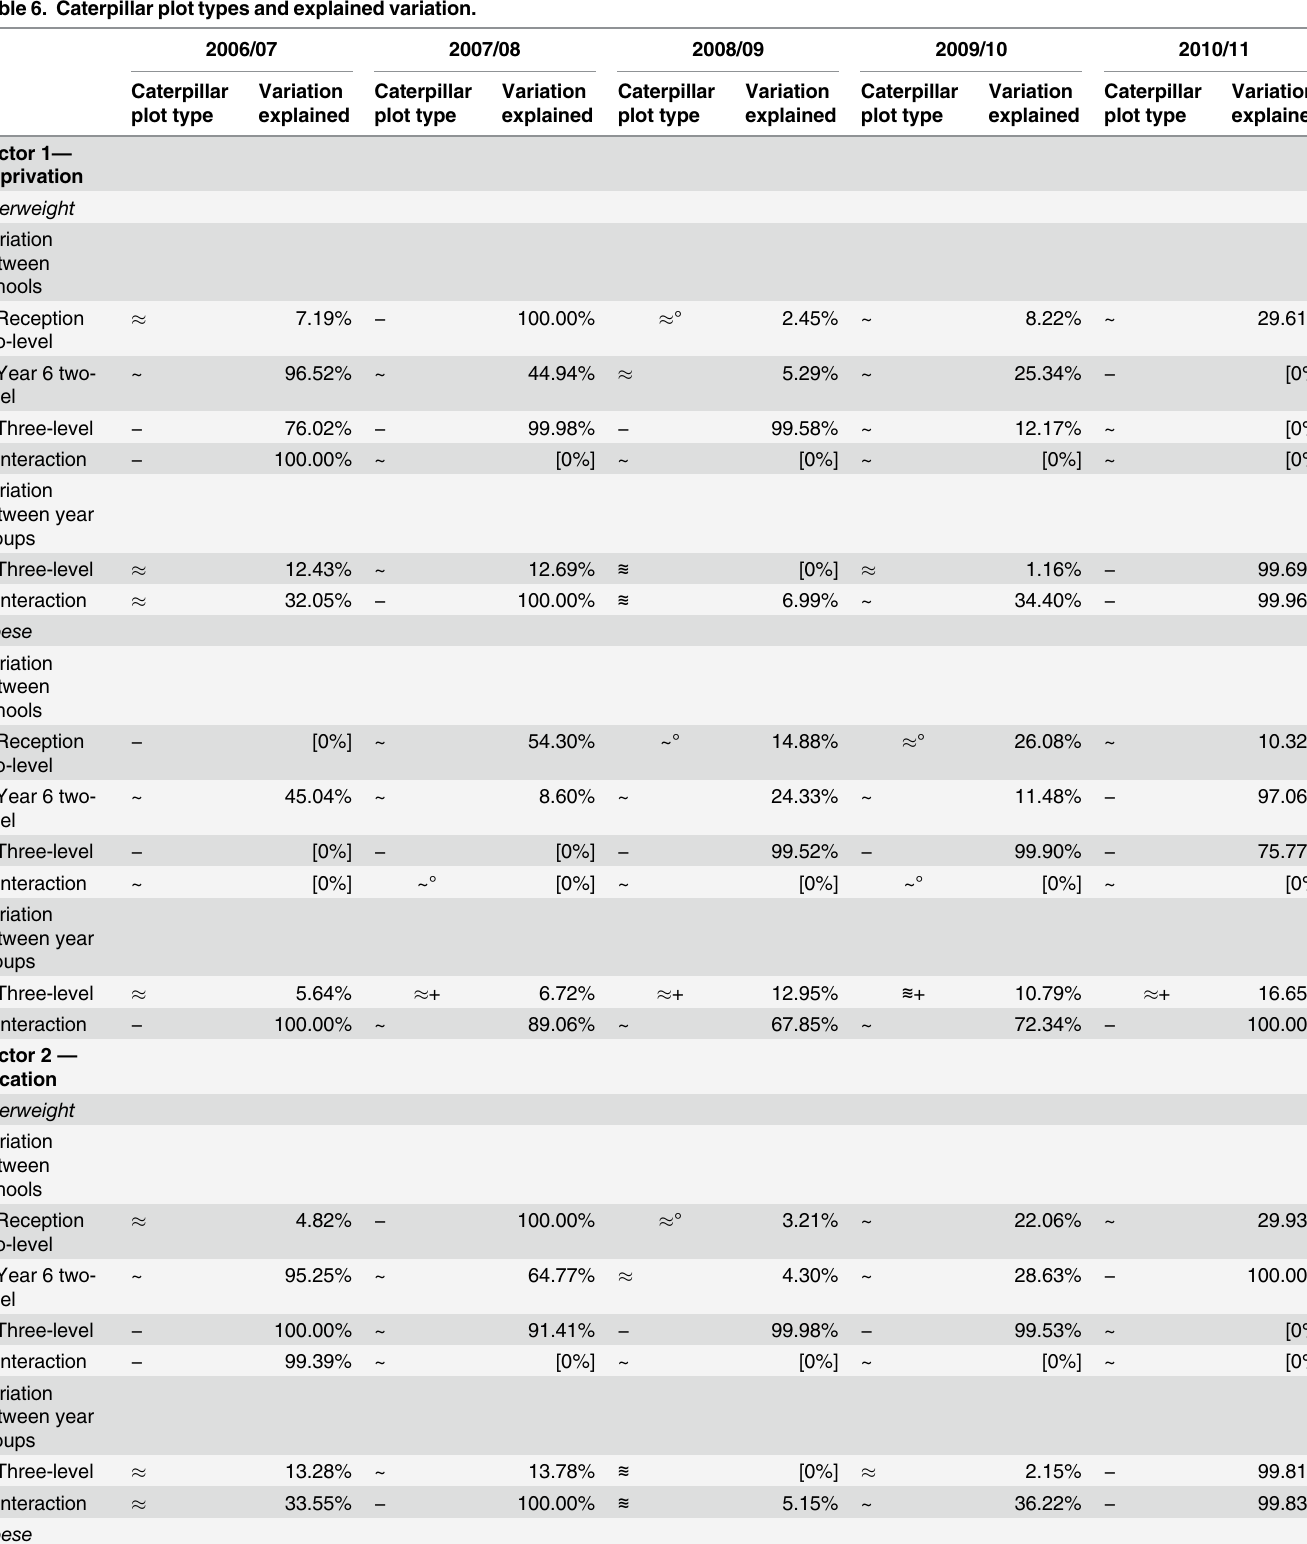
Table 6. Caterpillar plot types and explained